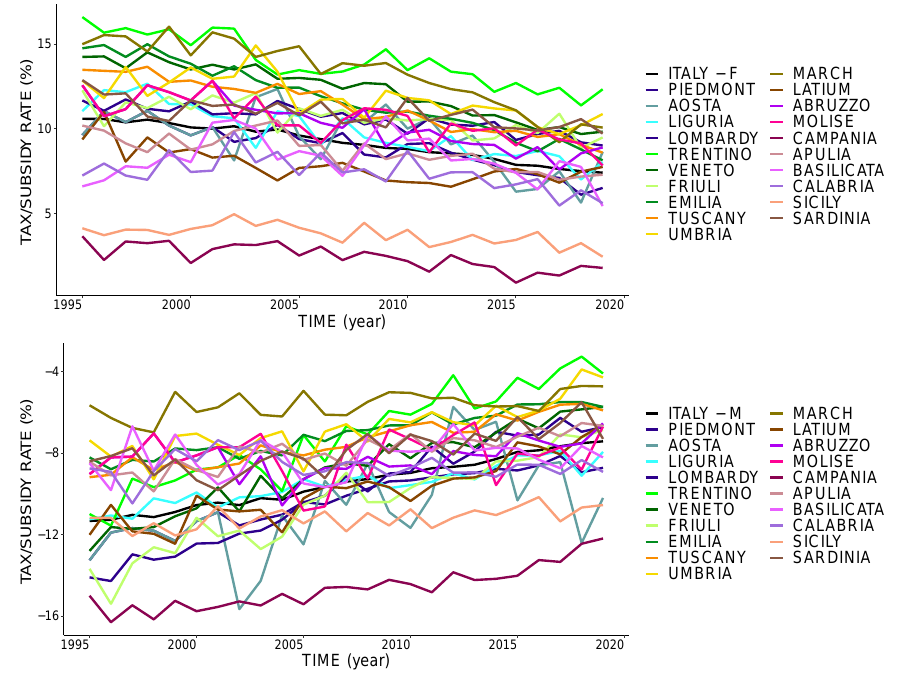
Figure A3. Tax/Subsidy rates for Italian female ( top ) and male ( bottom ) population aged 65 from 1995 to 2019 across regions (NUTS-2 level). Source: author’s own elaboration on data from ISTAT. Once tax/subsidy rate profiles are computed, TATSI index can be obtained by gender (Equation (4)) and regions (Equation (5), with ω t , a , g = 1 ). This makes possible to compare 20 TATSI profiles at macroarea (NUTS-1) and regional (NUTS-2) levels for the same gender (Figure A4).